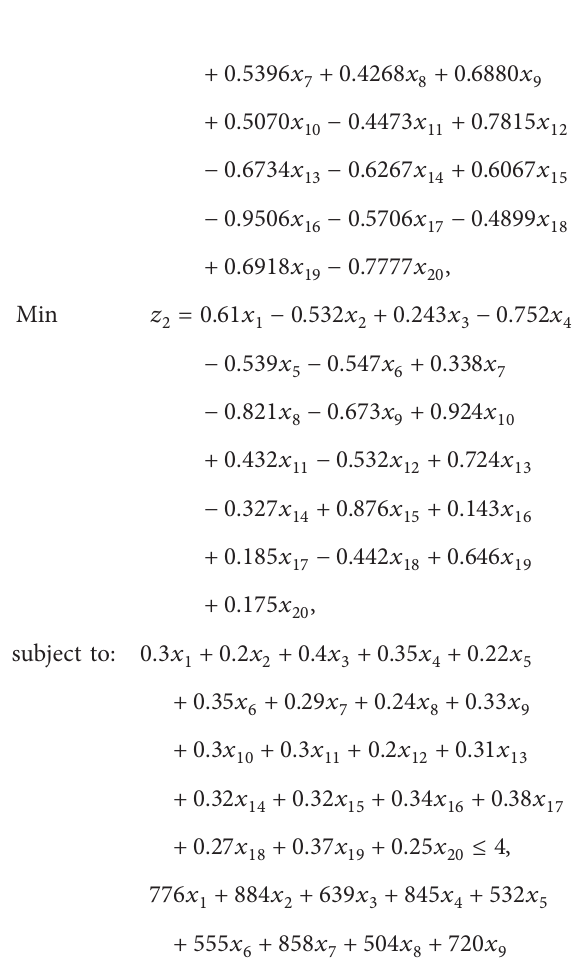
Figure 9: The environmental risk of the first project obtained by the fuzzy inference system.